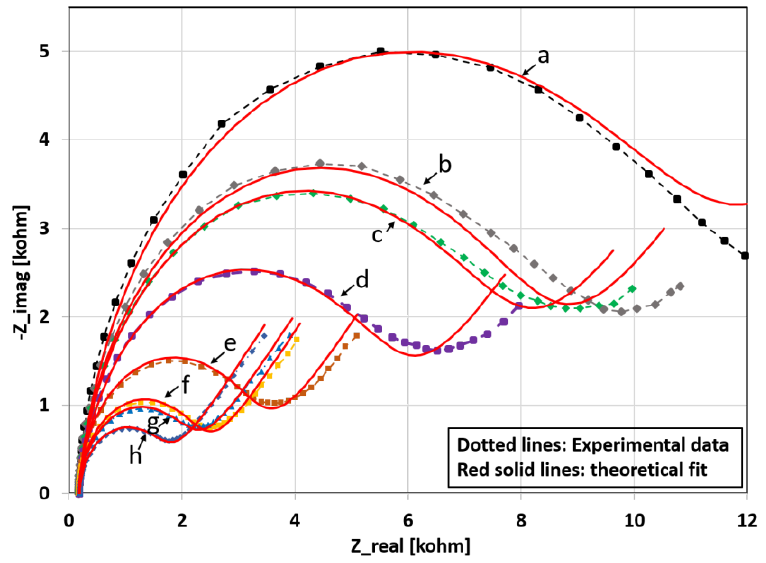
Figure 10. Post-lysozyme exposure Nyquist curves for different concentrations of lysozyme: ( a ) 0 µg/mL; ( b ) 0.25 µg/mL; ( c ) 0.50 µg/mL; ( d ) 1 µg/mL; ( e ) 2 µg/mL; ( f ) 5 µg/mL; ( g ) 10 µg/mL; and ( h ) 20 µg/mL. The dotted lines are the experimental data and the solid lines in red are theoretical curves based on the modified Randles circuit.